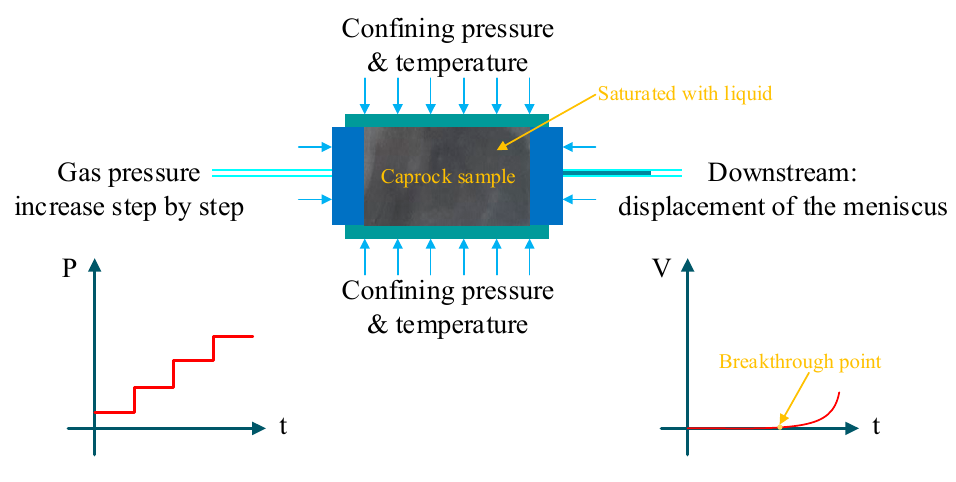
Figure 2. A step-by-step method for displacement pressure.